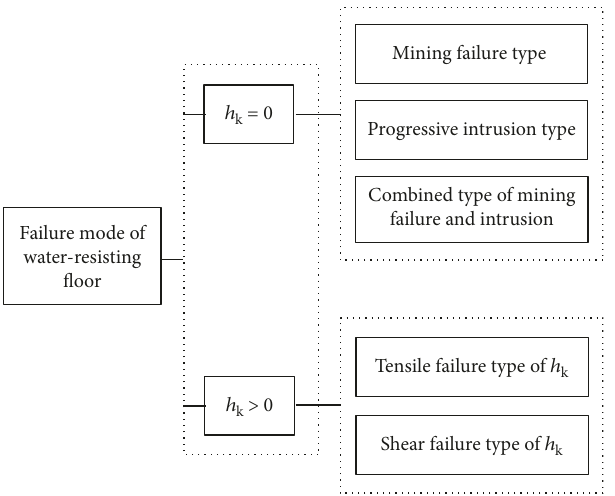
Figure 4: Main failure mode of the water-resistant fl